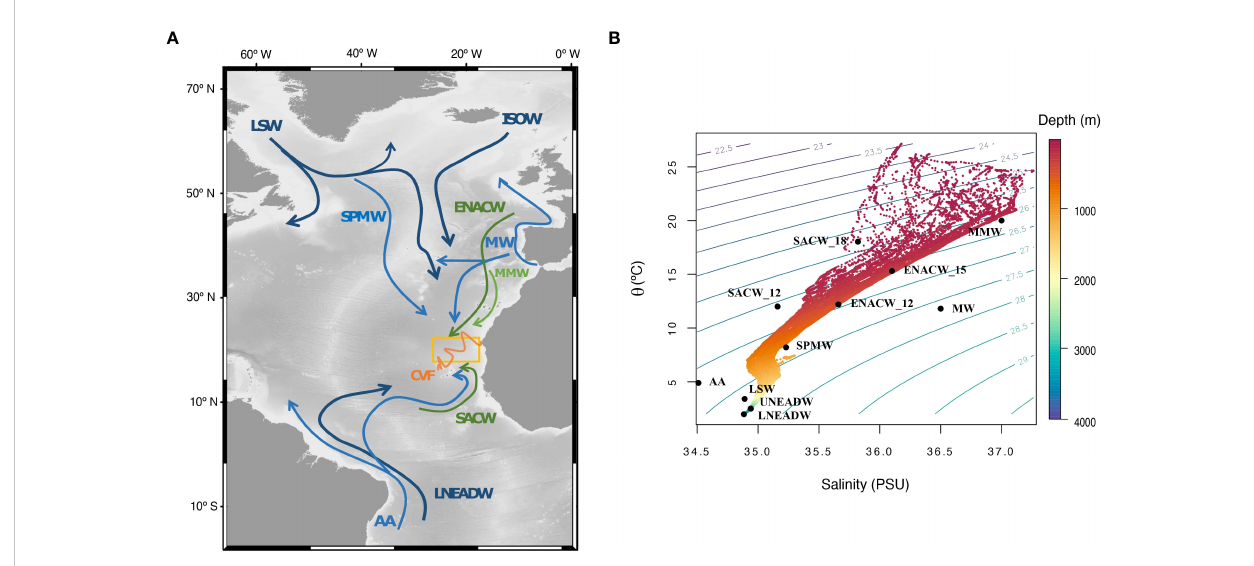
FIGURE 2 (A) Main water masses present in the CVFZ and (B) Potential temperature ( q °C) versus salinity (PSU) plot for the identi fi cation of the water masses intercepted during the FLUXES I cruise. In (A) arrows indicate the direction from its formation areas, corresponding to: Labrador Sea Water (LSW), Iceland Scotland Over fl ow Water (ISOW), Subpolar Mode Water (SPMW), Eastern North Atlantic Central Water (ENACW), Mediterranean Water (MW), Madeira Mode Water (MMW), Southern Atlantic Central Water (SACW), Antarctic Intermediate Water (AA) and Lower North East Atlantic Deep Water (LNEADW). The thickness and the color of the arrows indicates the bathymetric layer of each water mass. MMW: light green thin lines. Central waters: dark green thin lines. Intermediate waters: light blue thick lines. Deep waters: thicker dark blue lines. The yellow square represents the study area and the orange zigzag line is the position of the CVF at the time of sampling (taken from Burgoa et al., 2020). In (B) data was obtained from the continuous CTD pro fi les (1 salinity-temperature pair per meter). Contour isolines are sigma-theta values and the color indicates depth (dbar). Black dots represent the salinity and temperature of the pure water masses at their respective formation sites: Madeira Mode Water (MMW), Eastern North Atlantic Central Water of 15°C (ENACW_15) and 12°C (ENACW_12), Southern Atlantic Central Water of 18°C (SACW_18) and 12°C (SACW_12), Subpolar Mode Water (SPMW), Antarctic Intermediate Water (AA), Mediterranean Water (MW), Labrador Sea Water (LSW) and the Upper and Lower North East Atlantic Deep Water (UNEADW and LNEADW).